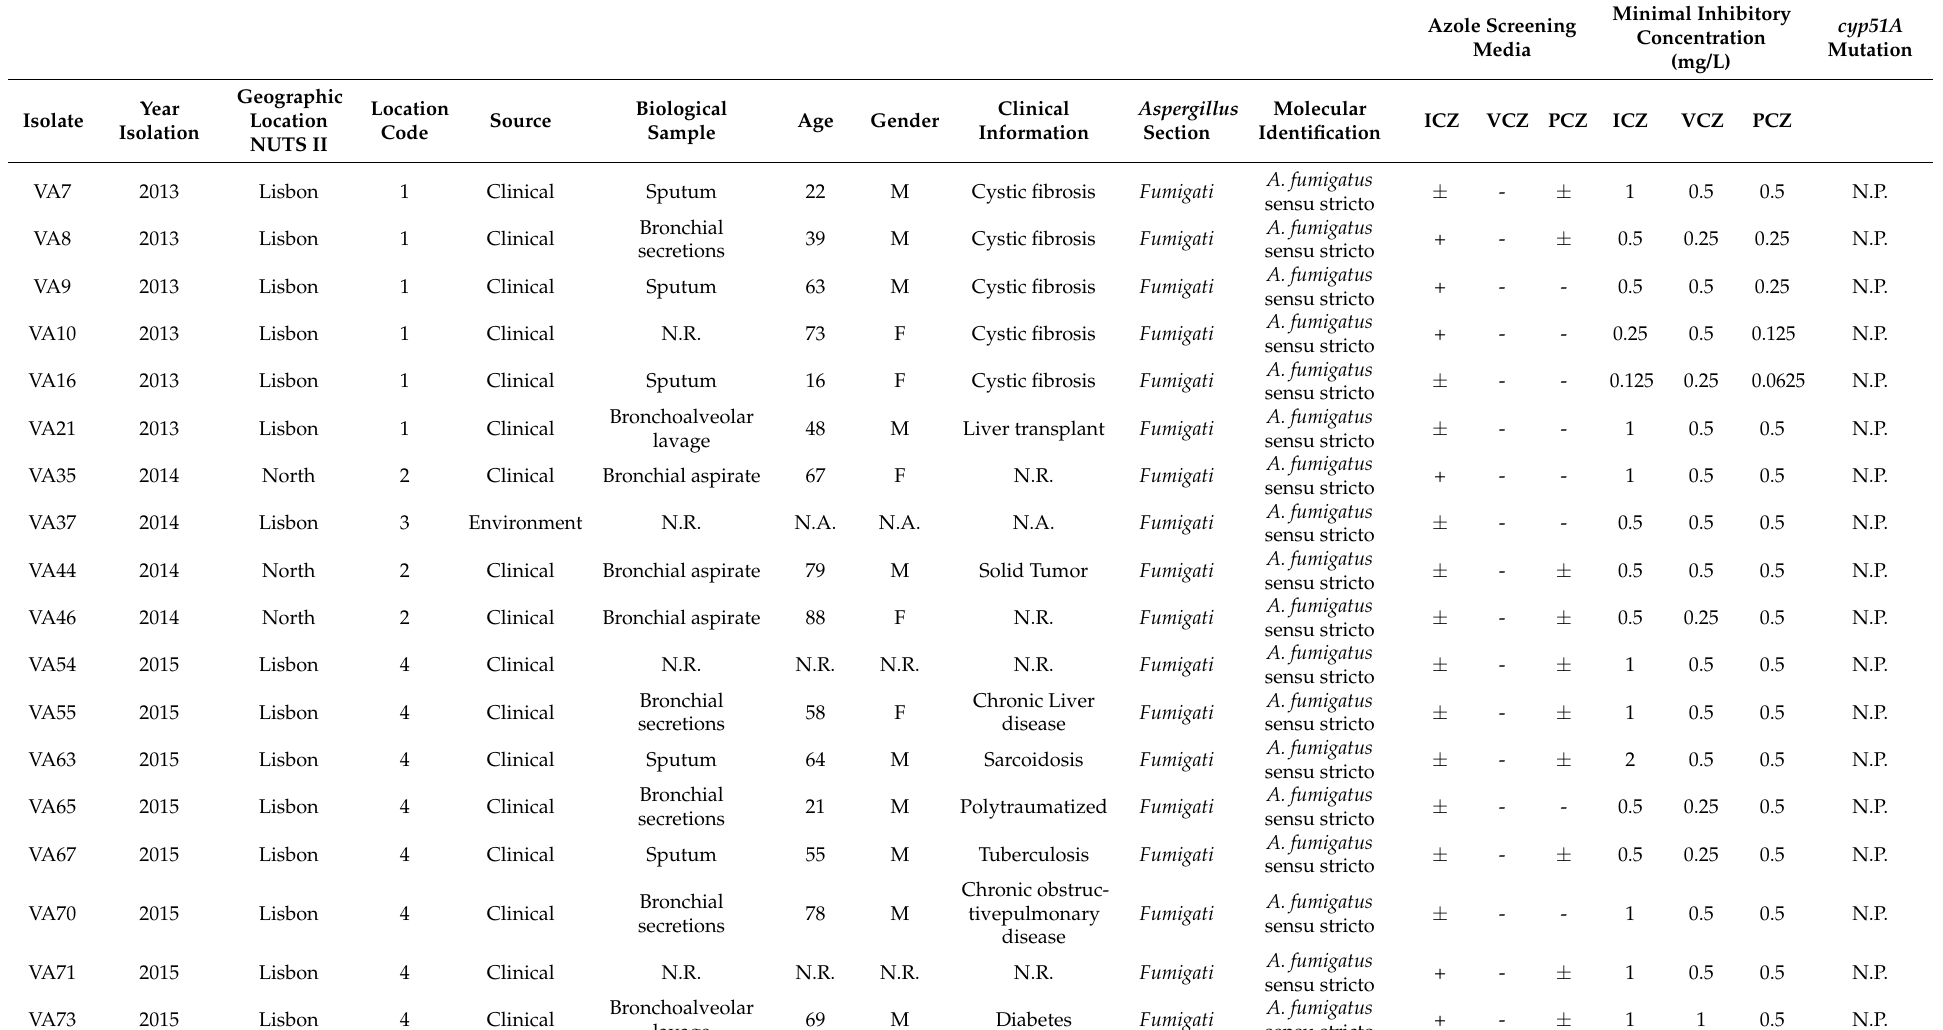
Table 4. Characterization of the isolates presenting growth on azole screening